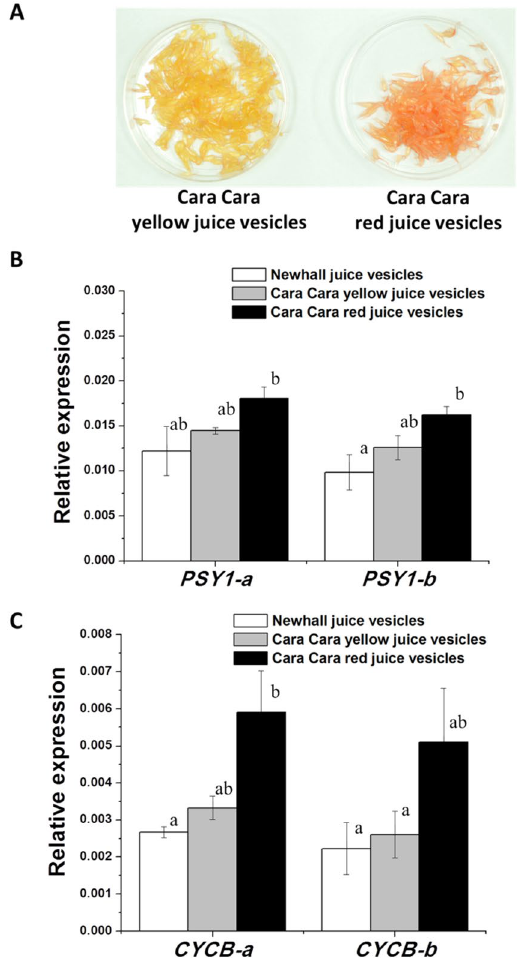
Figure 8. Expression of PSY1 and CYCB alleles in different colored juice vesicles at S6. ( A ) Different color of yellow and red juice vesicles from the same Cara Cara fruit. ( B ) Expression level of two alleles of PSY1 in Newhall juice vesicles and Cara Cara yellow, red juice vesicles. ( C ) Expression level of two alleles of CYCB in Newhall juice vesicles and Cara Cara yellow, red juice vesicles. The expression level of each of the PSY1 and CYCB allele was measured by quantitative real-time PCR using allele-specific PCR primers (Supplementary Table S1). The bars represent SE from three biological replicates. A significance test was conducted and values with the same letter indicates no significant difference at P <